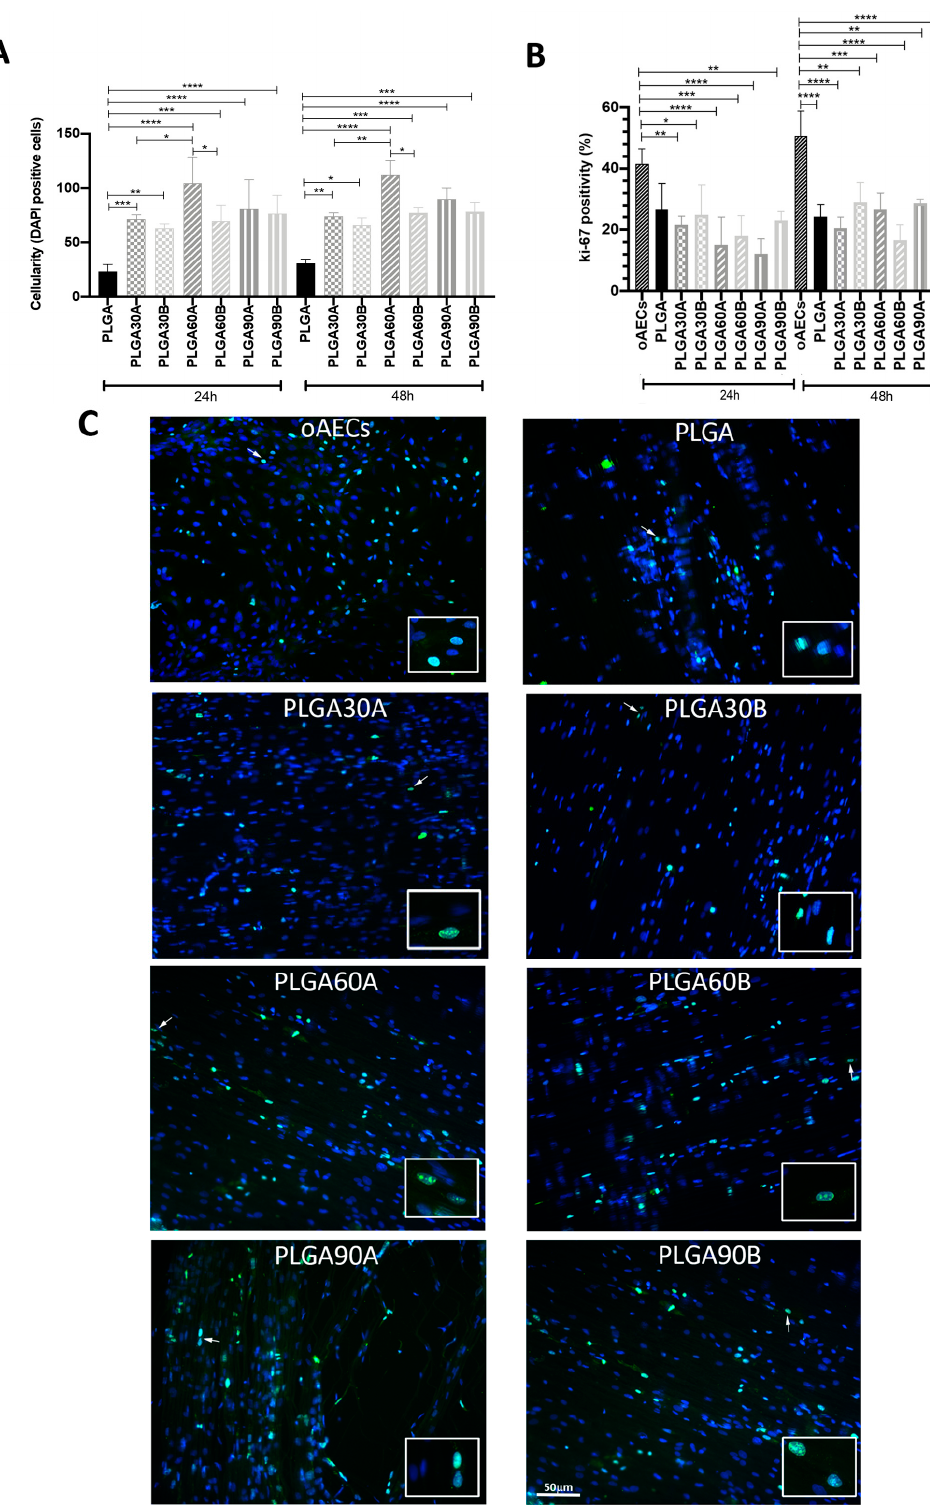
Figure 7. Cellularity and Proliferation index (PI) of untreated and treated PLGA microfibers. ( A ) Cellularity quantified within the analyzed PLGA microfibers, expressed as the total number of nuclei (DAPI stained) in a field of × 400 magnification after 24 h and 48 h of culture. ( B ) Proliferation index (PI) of oAECs cultured on Petri dishes (oAECs) or within the analyzed untreated (PLGA) or treated CAP samples. ( C ) Representative images of oAECs within the analyzed PLGA microfibers and Petri dishes showing Ki-67 positivity (green fluorescence) and cell nuclei counterstained in blue (DAPI); Scale bars = 50 µm. The insets show details of each sample (white arrows indicate the corresponding cells present in the insets at lower magnification) in which it is evident the co-localization of Ki-67 expression and nuclei (n = 3 for each type of sample/ time point, sample size: 15 mm × 7 mm). *,**,*** and **** Statistically different values between different studied groups for p < 0.05, p < 0.01, p < 0.001 and p < 0.0001, respectively.